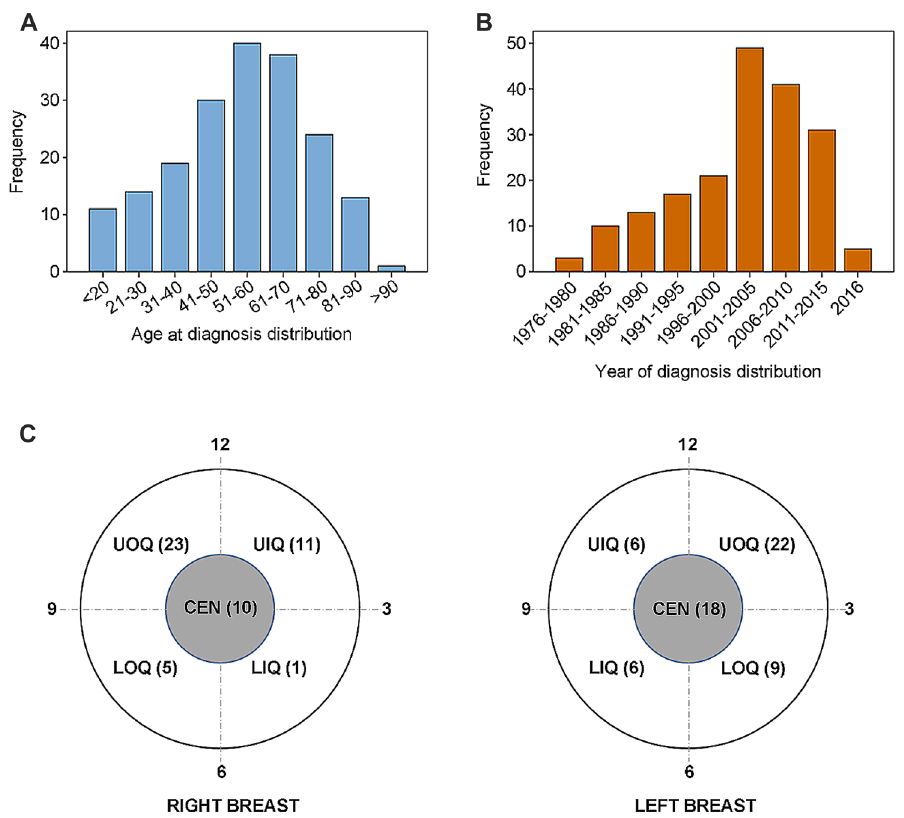
Figure 1. Clinicopathologic characteristics of study cohort. ( A ) Distribution of age at diagnosis. ( B ) Distribution of year of diagnosis. ( C ) Distribution of tumor location in the breasts. UIQ upper inner quadrant, LIQ lower inner quadrant, LOQ lower outer quadrant, UOQ upper outer quadrant, CEN nipple-areola